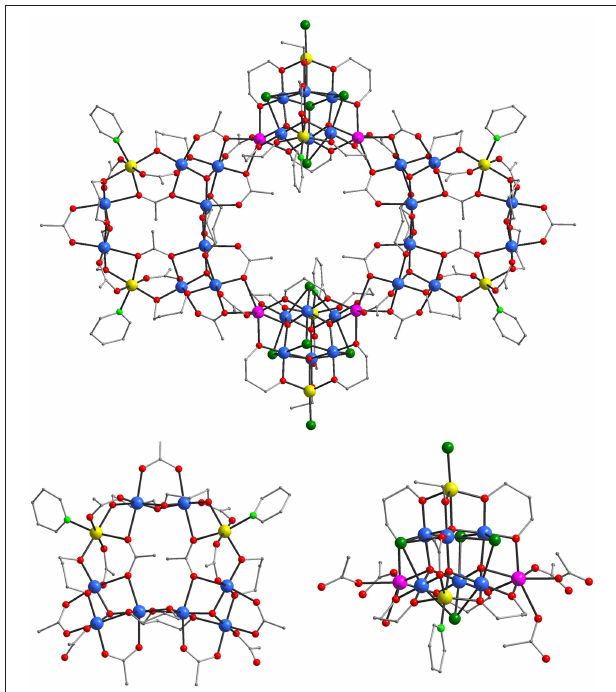
FIGURE 2 | Representations of the molecular structure of 3 (top) and its [Mn III 8 Co 2 ] loop (bottom, left ) and [Mn III 6 Mn II 2 Co II 2 ] supertetrahedral (bottom, right ) sub-units. Color code: Mn II purple, Mn III blue, Co II yellow, O red; N light green, Cl green, C gray. H atoms are omitted for